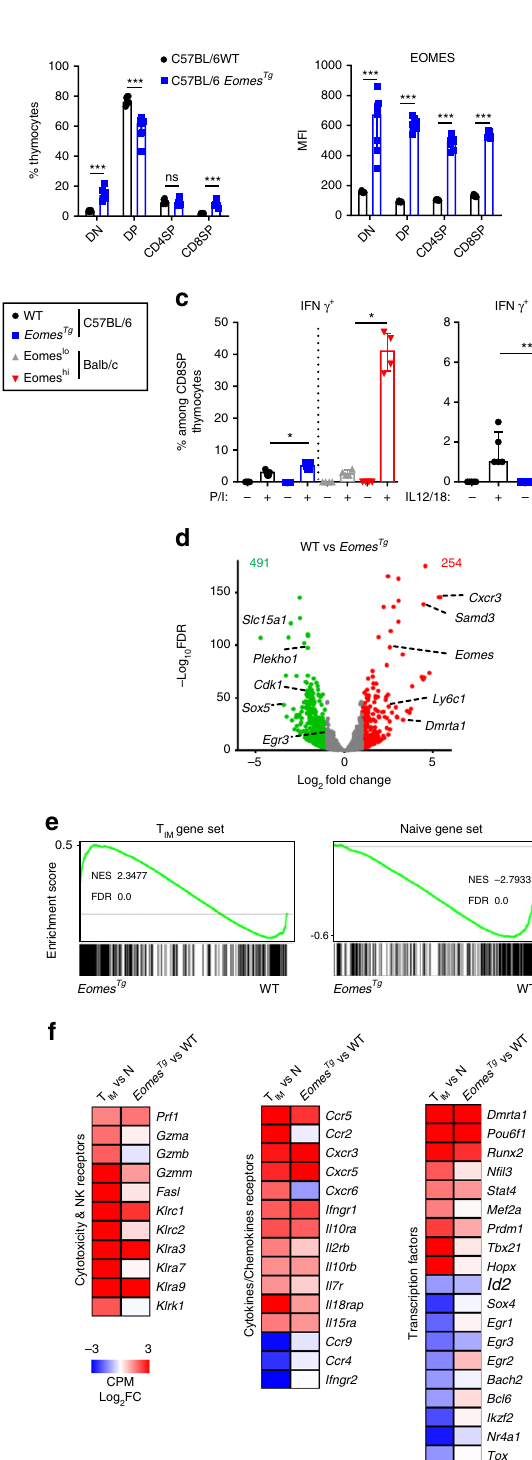
Mixed bone marrow chimera . CD3 ε − / − mice were irradiated twice at 600 cen- tigrays (cGy) before being injected intravenously with a 50:50 bone marrow mix- ture from WT CD45.1 and Smarca4 Δ T CD45.2 mice (Fig. 7d). Reconstitution was achieved at 6 weeks post-irradiation based on peripheral blood examination and IL-4c administration was started 10 weeks post-irradiation. Flow cytometry . Single-cell suspensions were stained to exclude dead cells (LIVE/ DEAD ™ Fixable Aqua Dead Cell Stain Kit, for 405nm excitation, Life Technolo- gies), and incubated with rat anti-mouse CD16/CD32 (BD, clone 2.4G2, dilution 1:100, catalog number 553141) and a surface antibody mix prepared in brilliant stain buffer (BD) for 20 min at 4°C in the dark. Except for sorting, cells were fi